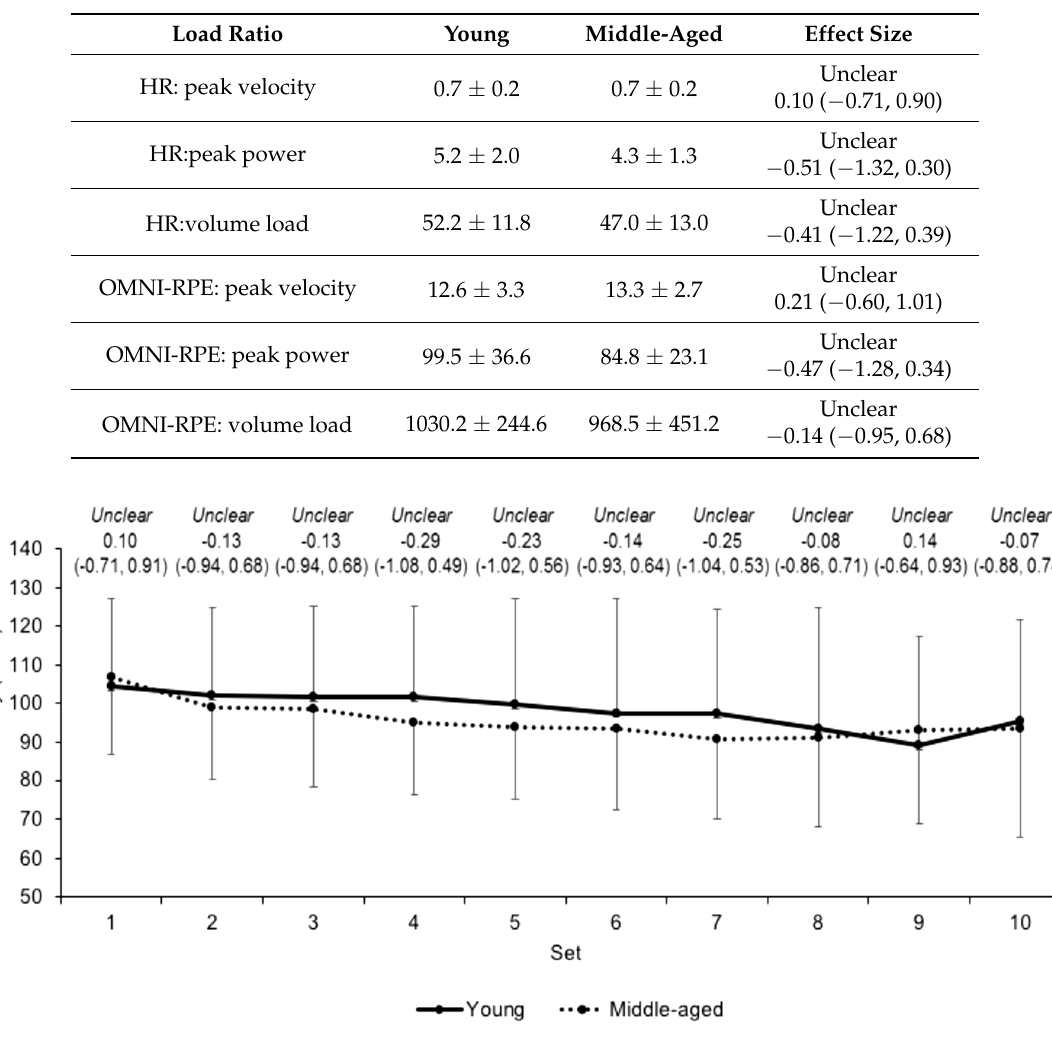
Figure 4. Peak velocity (mean ± SD) across each set in young and middle-aged groups. Qualitative descriptor, effect size, and upper and lower 90% confidence intervals are noted above.